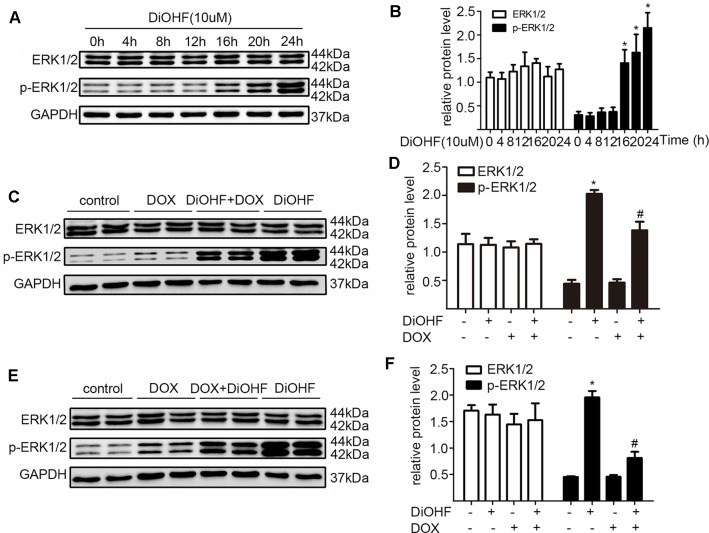
ERK1/2 participated in the protective effects of DiOHF. (A) DiOHF induced ERK1/2 activation in a time-dependent manner (n = 3). The H9C2 cells were treated with vehicle or DOX (1 µM) in the presence or absence of DiOHF (10 µM for 2 h prior to DOX exposure and 10 µM after 2 h of DOX exposure, respectively) for 24 h. The protein levels of phospho-ERK1/2 (p-ERK1/2) and ERK1/2 were measured by Western blot (C and E; n = 3). (B, D, and F; n = 3) Quantitative results of ERK1/2 and p-ERK1/2. The data were analyzed by ANOVA and expressed as the mean ± SEM. *P < 0.05, compared with control. #
P < 0.05, compared with DOX.